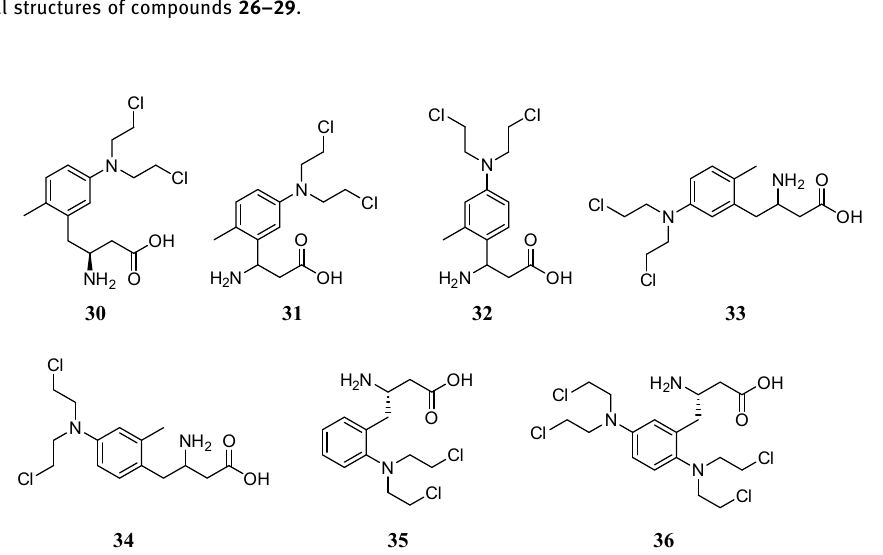
Figure 12: Chemical structures of compounds 30 – 36.